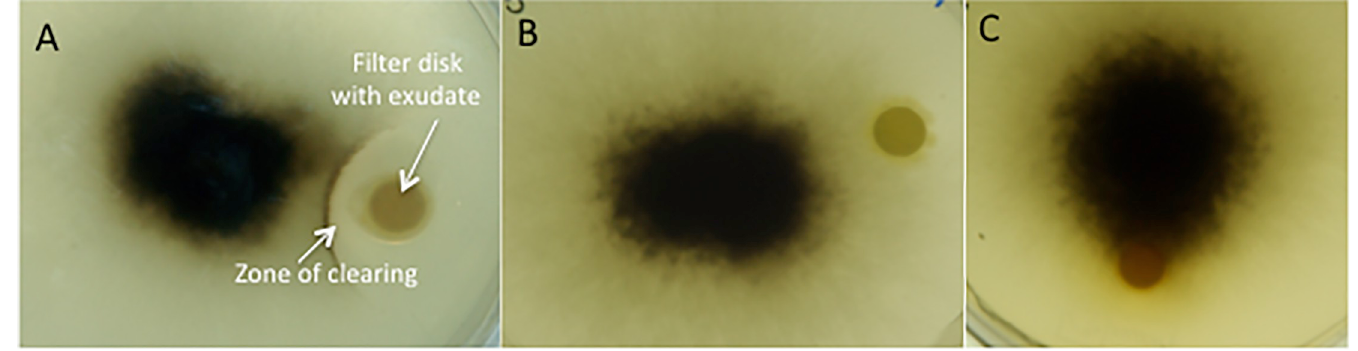
Fig 1. Representative images of Colletotrichum graminicola in agar disk diffusion assays with water soluble exudates of (A) kochia ( Kochia scoparia ), (B) velvetleaf ( Abutilon theophrasti ), and (C) giant ragweed ( Ambrosia trifida ).